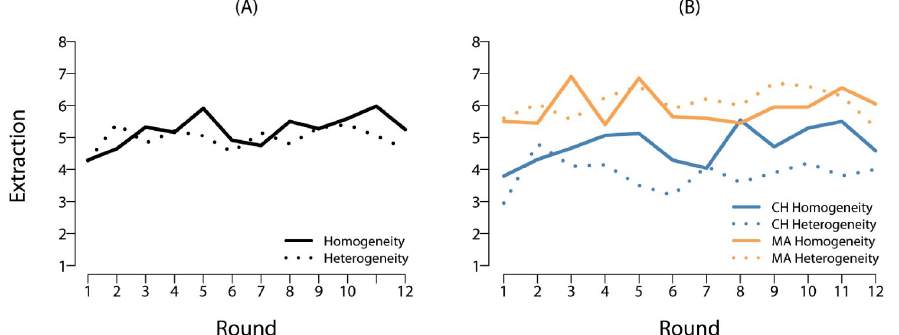
Fig 1. Extraction by round. (A) Mean extraction decisions of fishers under sociocultural homogeneity (groups of fishers from only the own village) and heterogeneity (groups of fishers from own and other village) over time. (B) Mean extraction decisions of fishers from Chwaka village (CH) and Marumbi village (MA) under sociocultural homogeneity and heterogeneity over